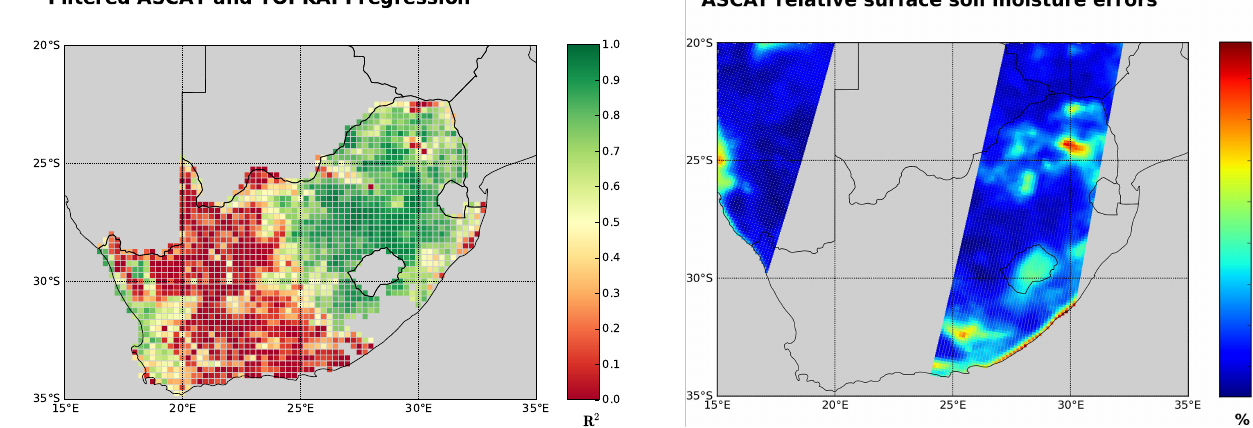
Fig. 18. Estimated error of the relative surface soil moisture retrieval from ASCAT. The satellite overpass matches that shown in Fig. 9.